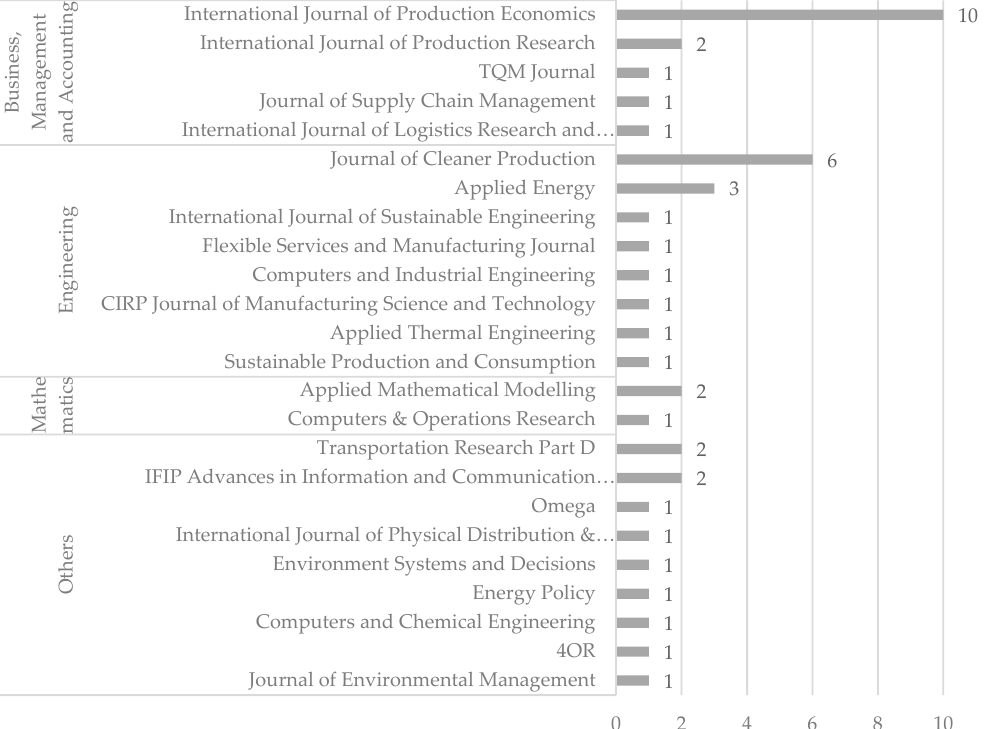
Figure 7. Classification output.